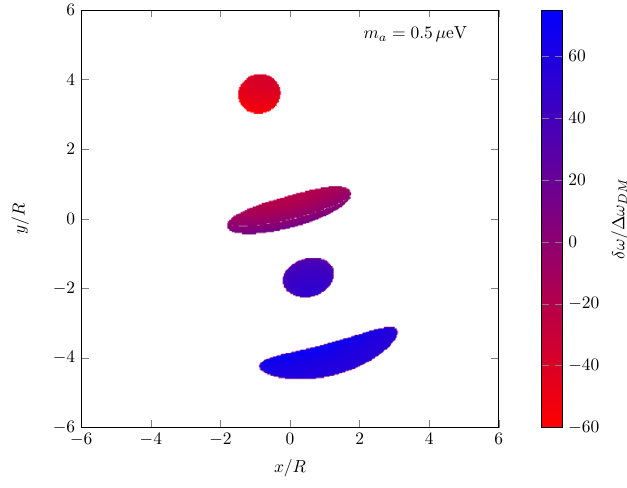
Figure 4 . Image of Doppler shift. The red/blue shift in frequency as seen in the image plane at a single moment in time. The frequency shift was computed using eq. (3.8). The other model parameters are the same as in figure 2. We show the frequency shift relative to that set by dark matter velocity dispersion: ∆ ω DM = 1 v 2 m a with v 0 = 6 × 10 − 4 corresponding to a dark matter 0 2 velocity v 0 = 200 km sec − 1